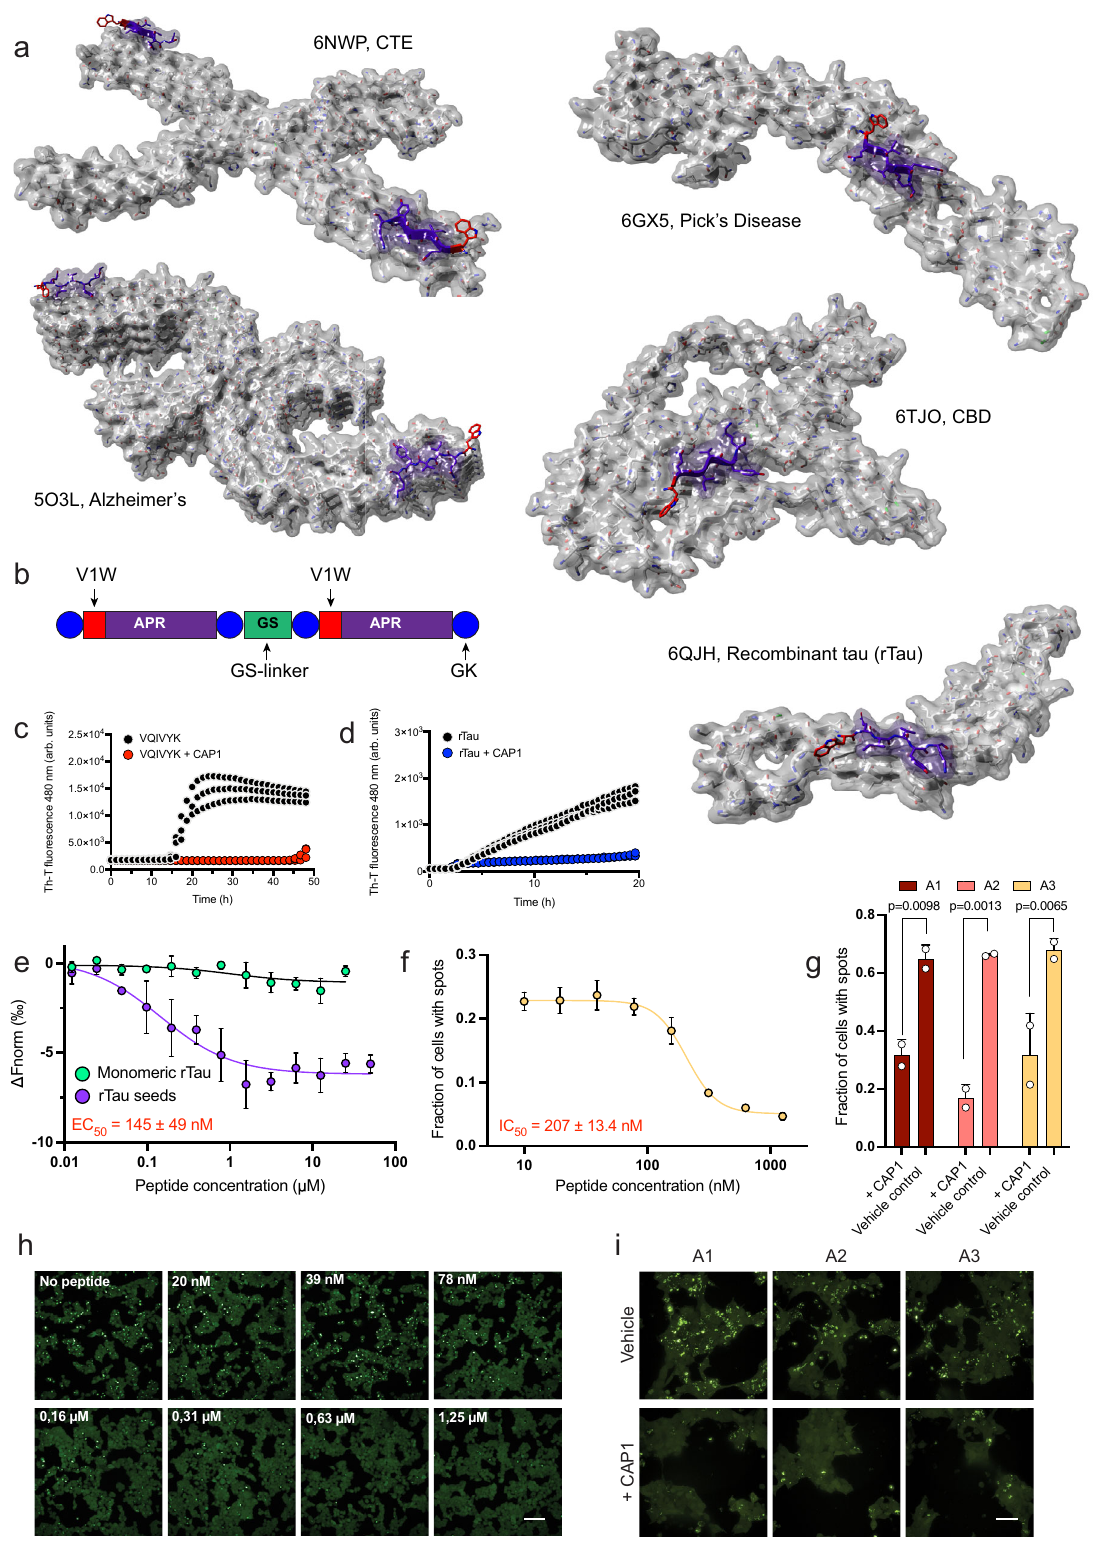
controls. Similarly, no signi fi cant morphological differentiation was observed when transfecting with either tau 2N4R , tau RD or any of negative constructs (Fig. S8f – j), respectively, thus further supporting the notion that apart of simply participating in co- aggregation with cellular tau inclusions, these proteins may also actively enhance cellular susceptibility to tau